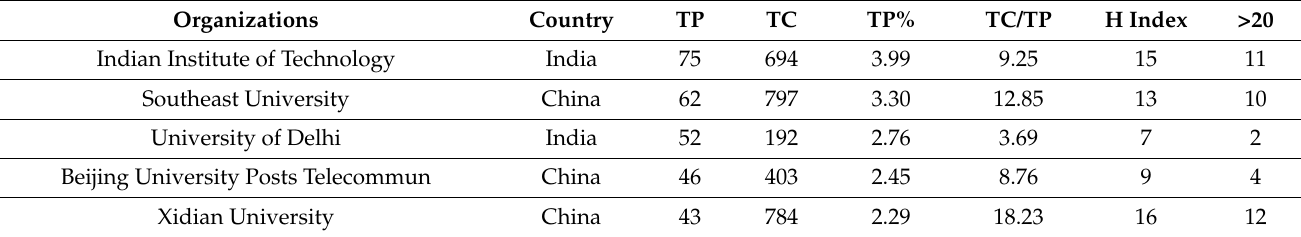
Table 3. Most productive universities in Fractional